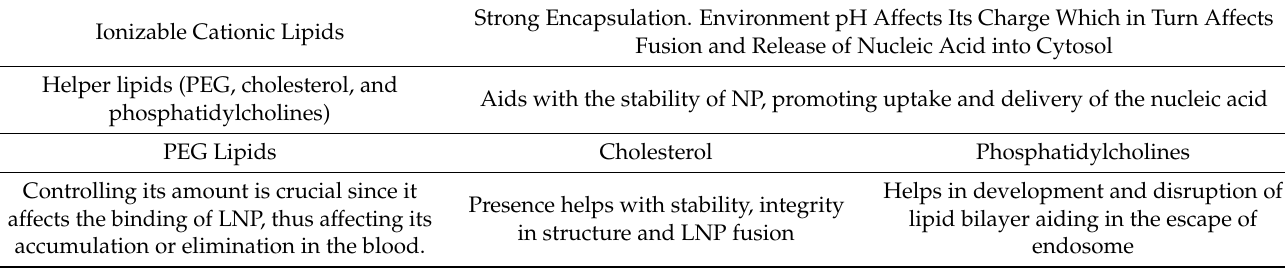
Table 2. Composition of lipid nanoparticles (LNP)